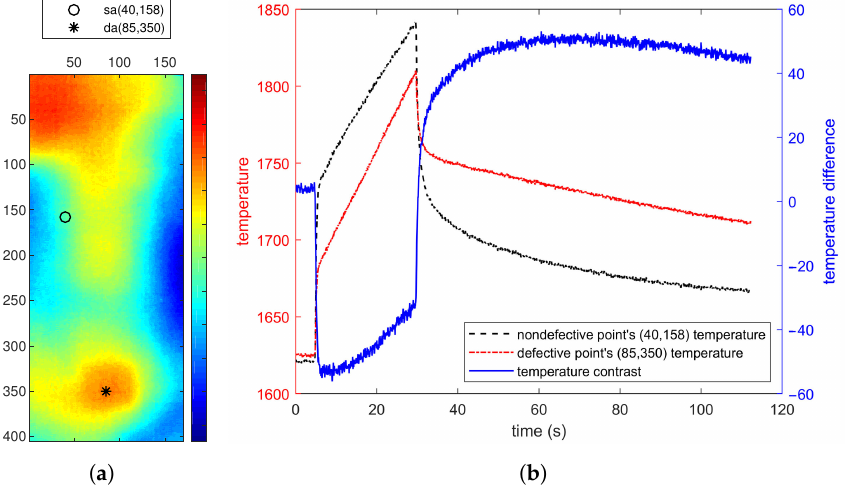
Figure 7. ATC; experiment 1. ( a ) Selected points. ( b ) Temperature-time graph and thermal